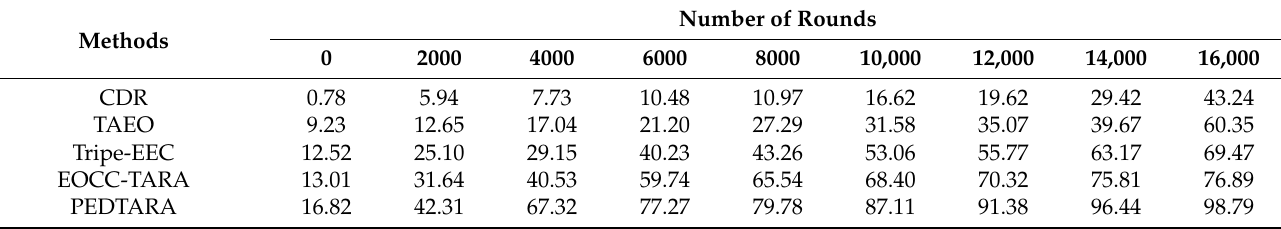
Table 12. Percentage of heated nodes.